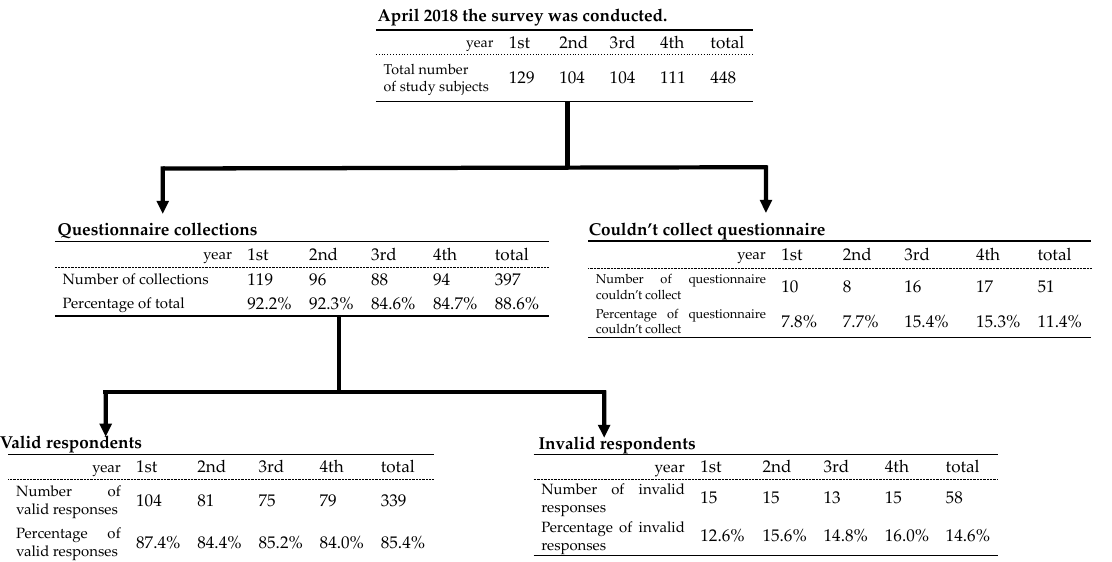
Figure 1 Number and Percentage of Respondents and Number and Percentage of Valid Respondents Figure 1. Number and Percentage of Respondents and Number and Percentage of Valid